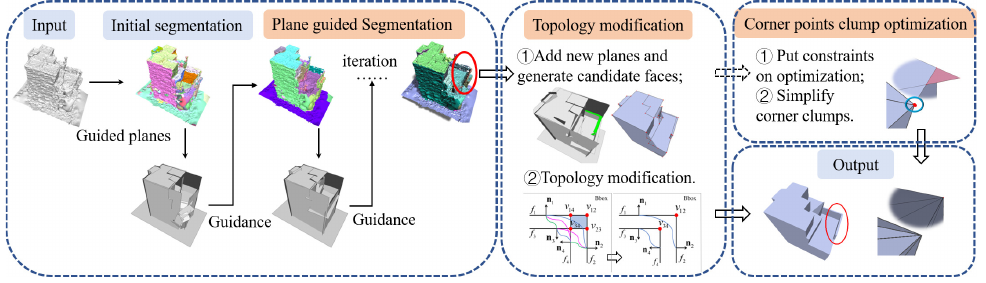
Figure 1. Building mesh polyhedron construction process.